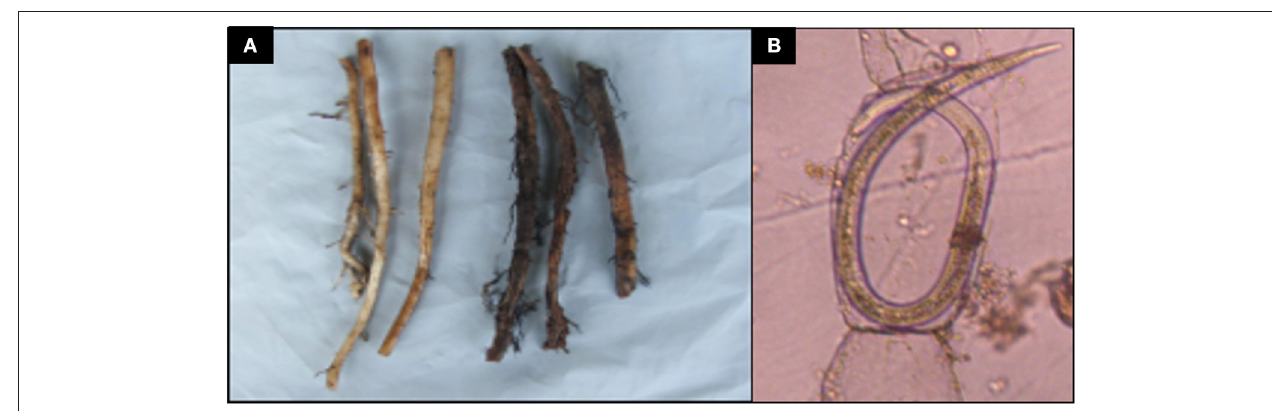
FIGURE 3 | Banana root damage caused by Radopholus similis . (A) Healthy-looking banana roots (left) and those having necrotic lesions associated with Radopholus similis infection (right) . (B) Female R. similis in root cortical tissues of banana plants.